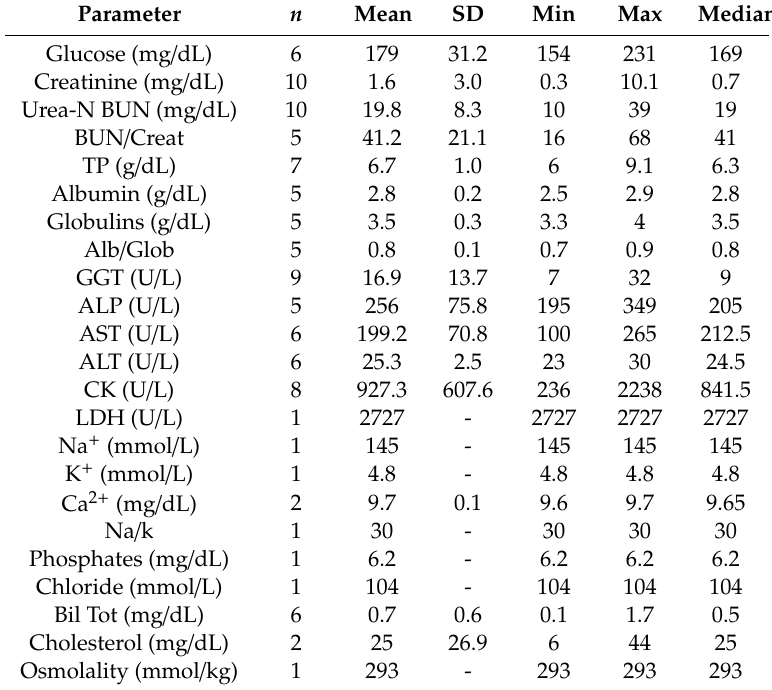
Table 2. Biochemical values of crested porcupine blood. For each parameter, the mean, the standard deviation (SD), minimum (Min) and maximum (Max) value, and the median are reported.